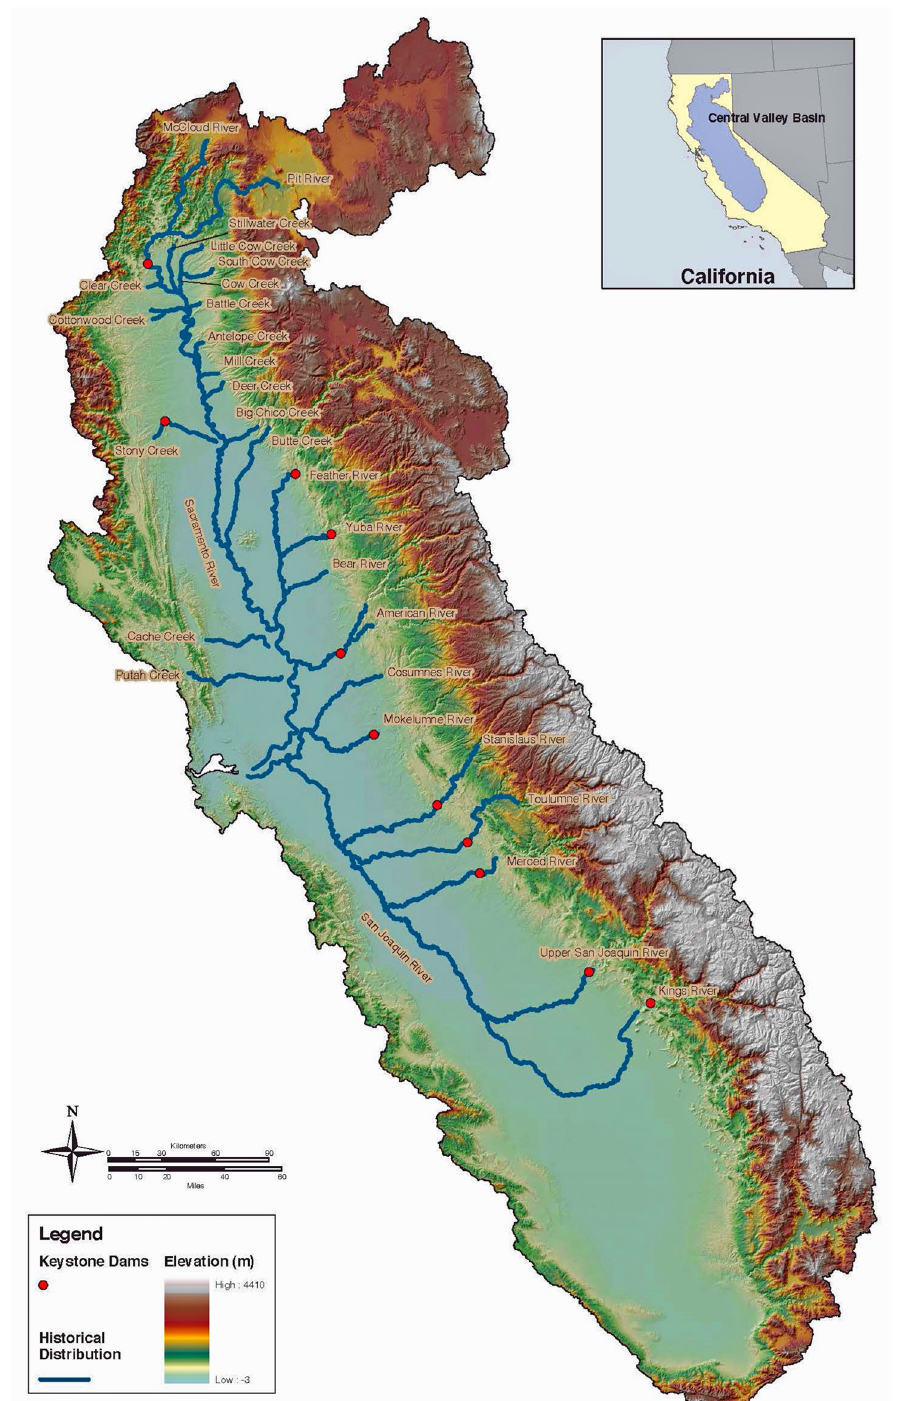
Fig 2. Historical distribution of Central Valley fall-run Chinook salmon ESU excludes San Francisco Bay, from NOAA Fisheries, Southwest Fisheries Science Center.